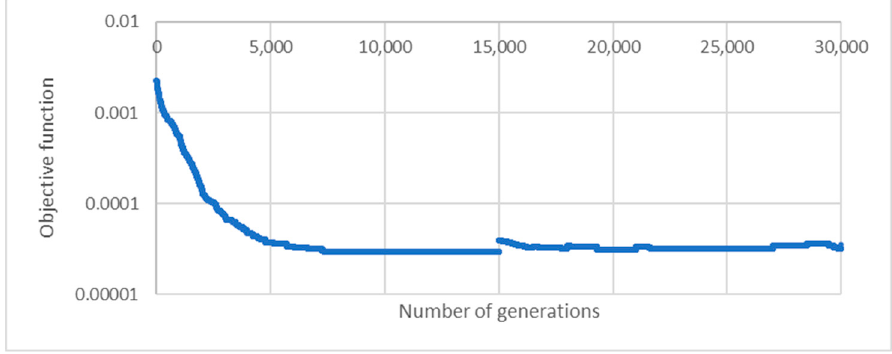
Figure 8. Objective function value against the number of evolution strategy generations for Case 1.2.